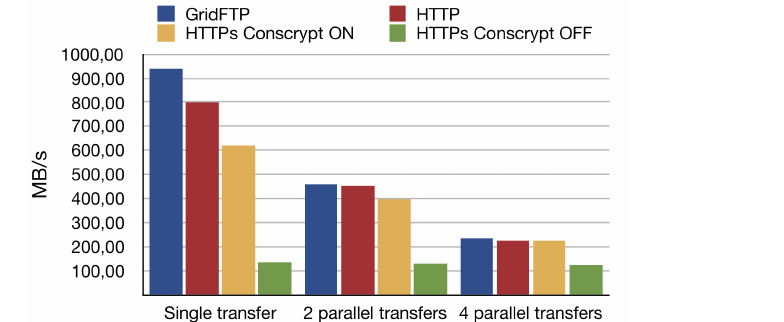
Figure 4. The average transfer rate observed after running sequential and parallel transfers against Globus GridFTP and StoRM WebDAV HTTP and HTTPS endpoints, using gfal-copy to drive the transfers.